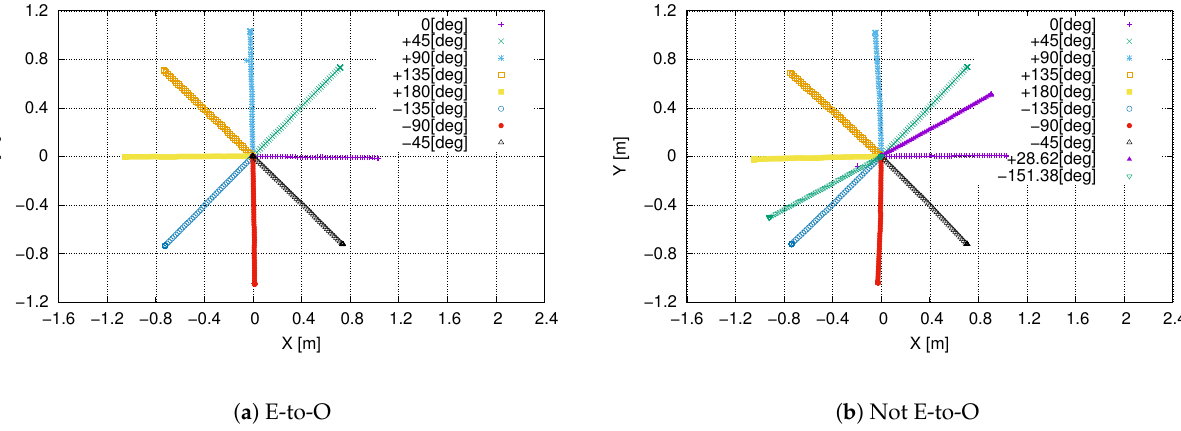
Figure 8. The robot trajectory during each travel direction with 6-wheeled Omni wheel robots.